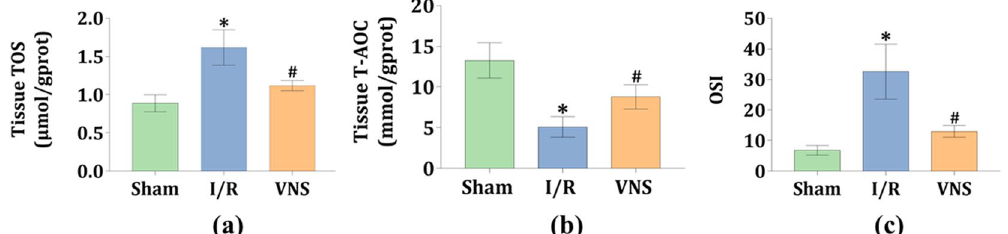
Figure 4. VNS improves redox status in the kidneys after hepatic I/R injury. The effect of VNS on the levels of ( a ) TOS and ( b ) T-AOC in kidney tissues is shown. ( c ) The OSI values is shown. Data are expressed as mean ± SD. *p < 0.05 versus the Sham group; # p < 0.05 versus the I/R group. TOS total oxidant status, T-AOC total antioxidant capacity, OSI oxidative stress